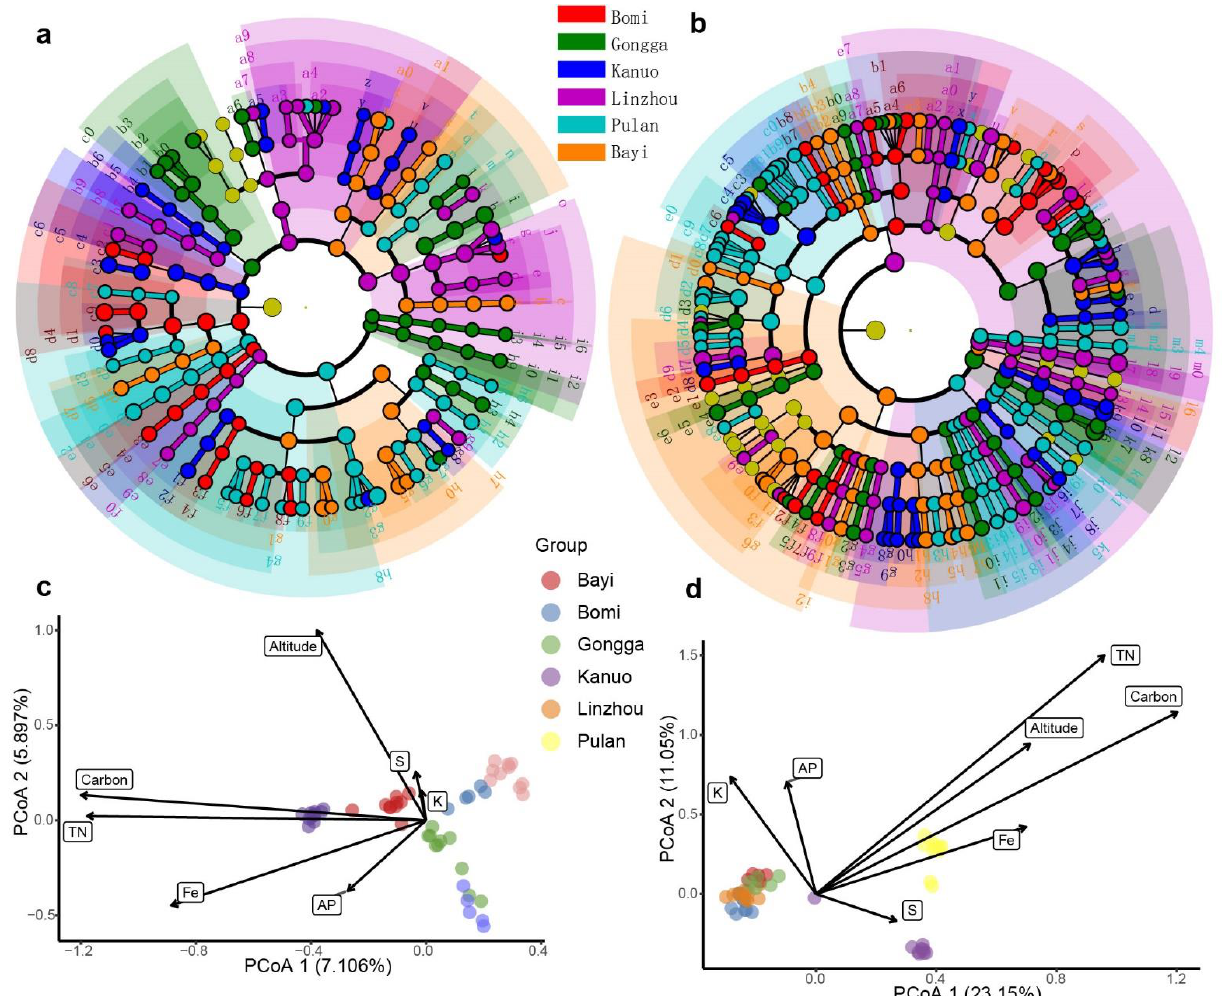
Figure 4. ( a ) A linear discriminant analysis (LDA) effect size (LEFSe) taxonomic cladogram compar- ing the best-discriminated bacterial taxa representing different geographical locations. Significantly discriminant taxon nodes are colored according to the highest-ranked group for that taxon and ( b ) LDA effect size (LEFSe) taxonomic cladogram comparing the best-discriminated fungal taxa repre- senting different geographic locations. Significantly discriminant taxon nodes are colored according to the highest-ranked group for that taxon. A distance-based redundancy analysis (RDA) diagram depicting ( c ) bacterial communities of barley in relation to various measured environmental varia- bles from six different geographical locations and ( d ) fungal communities of barley in relation to various measured environmental variables.